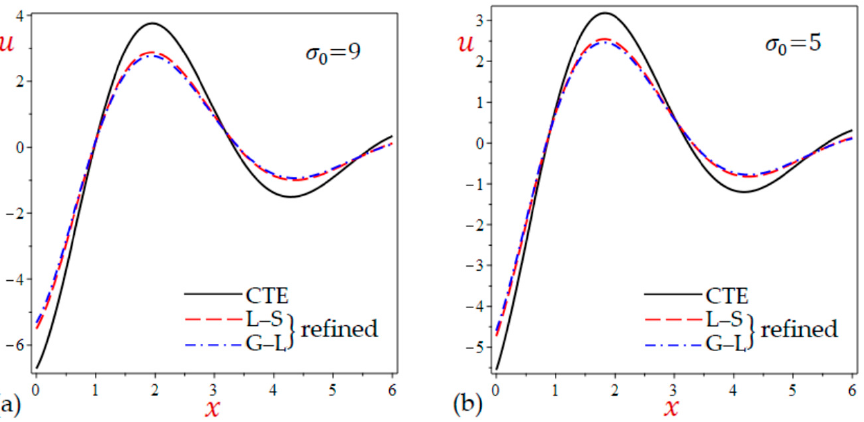
Figure 2. Effect of initial stress σ 0 on the horizontal displacement u of the rotating half-space with initial pressure ( 𝓅 = 10 ) ( a ) 𝜎 (cid:2868) = 9 ; ( b ) 𝜎 (cid:2868) = 5 .